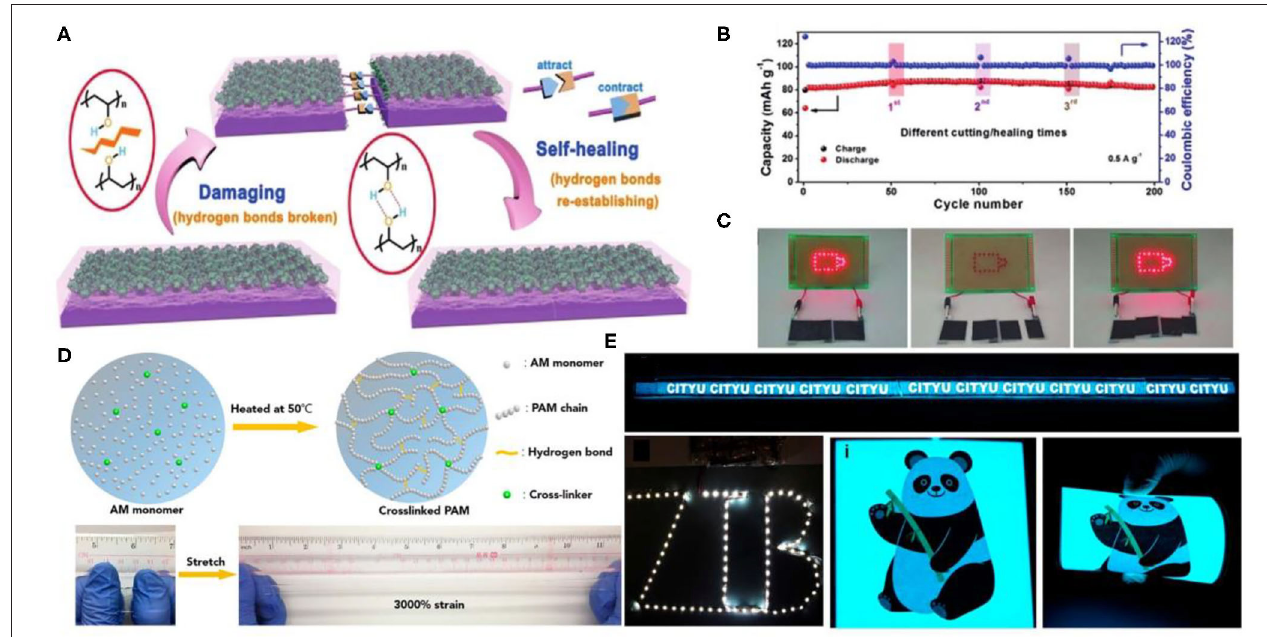
FIGURE 2 | (A) Illustration of ZIBs. (B) Cycle performance of the self-healing ZIBs at original state and after multiple rounds of cutting/self-healing. (C) Photographs of the two self-healing ZIBs in series powering an LED array before cutting (light on), after cutting (light off), and after self-healing (light on again). Reprinted with permission from Huang et al. (2019). Copyright (2019) John Wiley and Sons. (D) Schematic diagram and characterization of PAM-based electrolyte. (E) Eight yarn batteries were connected in a series to power a 1m long electroluminescent panel, a long LED belt, and electroluminescent pane under different bending conditions. Reprinted with permission from Li et al. (2018a). Copyright (2018) American Chemical